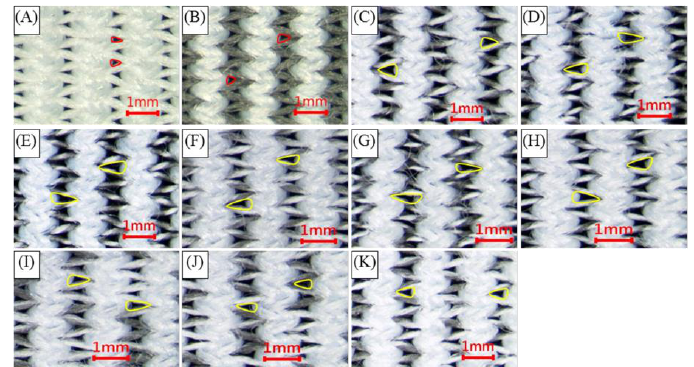
Figure 10. Surficial observation of the functional elastic knits that are made of ( A ) quick-dry yarn; ( B ) bamboo charcoal yarn; ( C ) 20 T.P.I. B-wrapped yarn; ( D ) 25 T.P.I. B-wrapped yarn; ( E ) 30 T.P.I. B-wrapped yarn; ( F ) 20 T.P.I. Q-wrapped yarn; ( G ) 25 T.P.I. Q-wrapped yarn; ( H ) 30 T.P.I. Q-wrapped yarn; ( I ) 5 T.P.I. B/Q-twisted yarn; ( J ) 10 T.P.I. B/Q-twisted yarn; and ( K ) 15 T.P.I. B/Q-twisted yarn. The small pore size is indicated in red drop-like triangles and the large pore size is indicated yellow drop-like triangles.